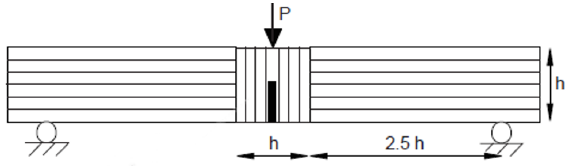
Figure 1. Single edge notched beam [1].